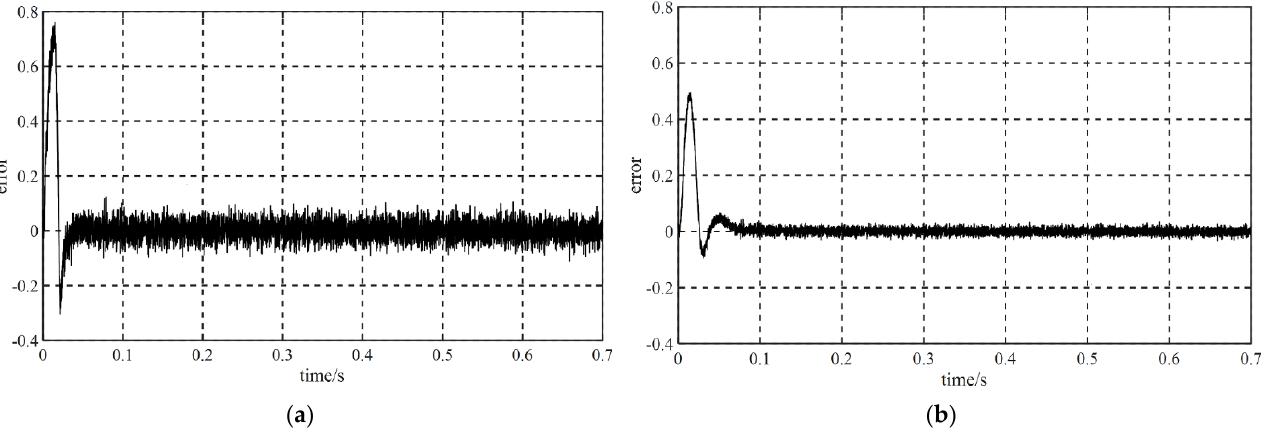
Figure 20. Comparison of the speed-tracking errors of two systems: ( a ) Traditional SMO system and ( b ) ST-SMO system.